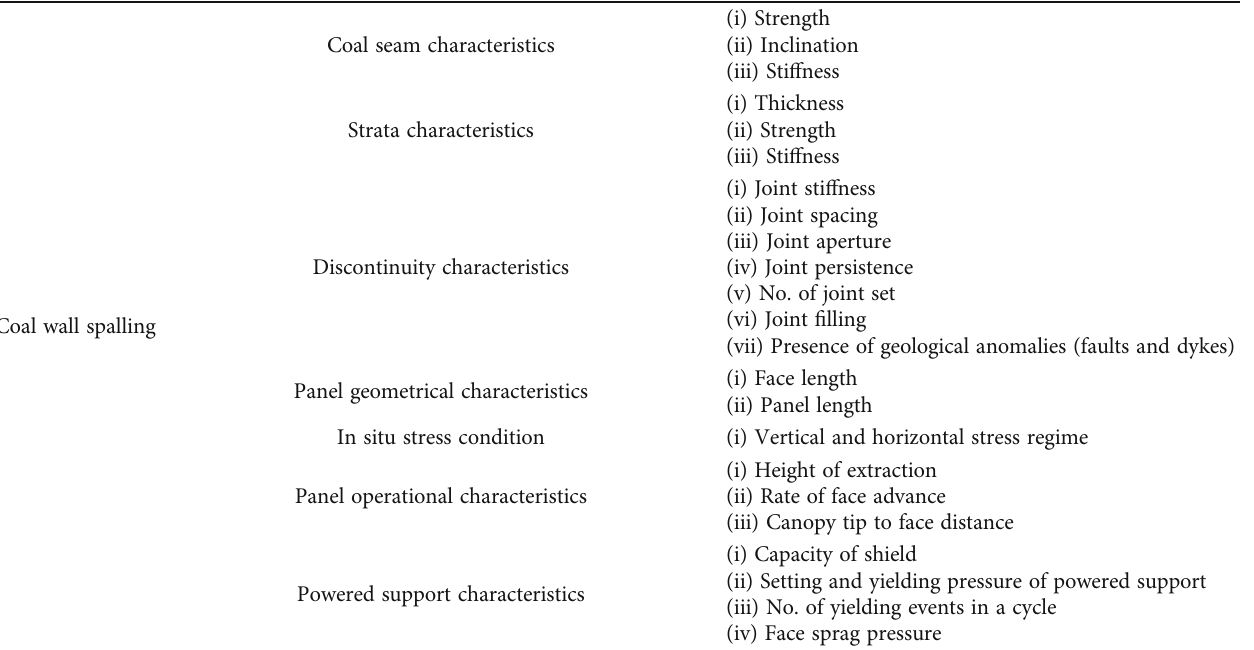
Figure 10: Load development on the shield for 90m of face extraction. Table 3: Key parameters that govern coal wall